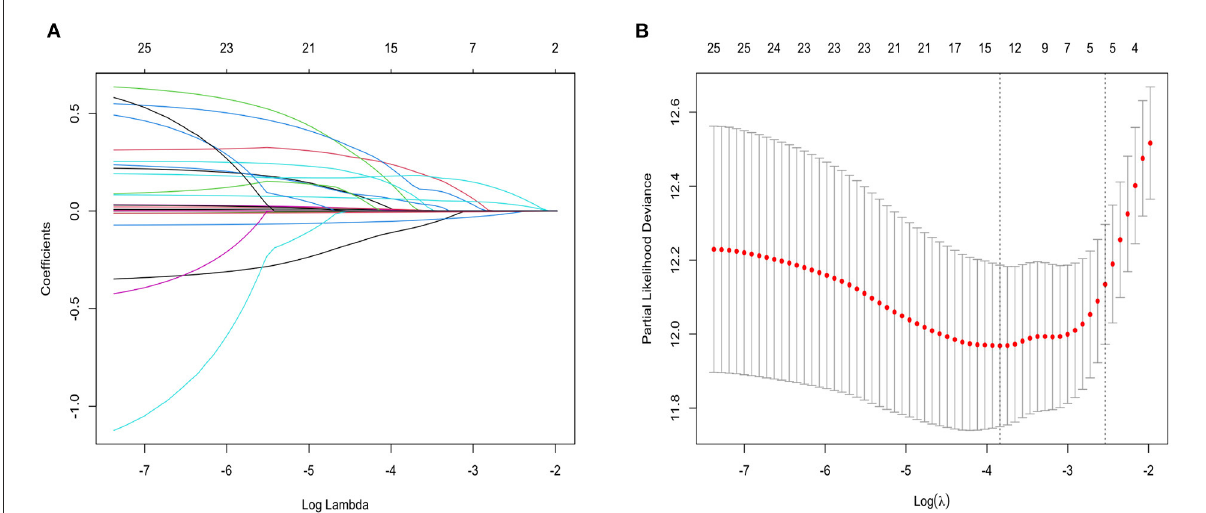
FIGURE1 (A) Lasso regression fitting Cox regression model; (B) Tenfold cross validation. The curves in (A) represent each variable that enters lasso regression analysis. The two vertical dashed lines in (B) represent the minimum penalty value ( λ value) and the penalty value at the first standard deviation respectively. In (A) , the point where the vertical line corresponding to the position of the penalty value intersects the curve is the number of filtered variables, and the ordinate of the corresponding intersection is the regression coefficient of the variable.